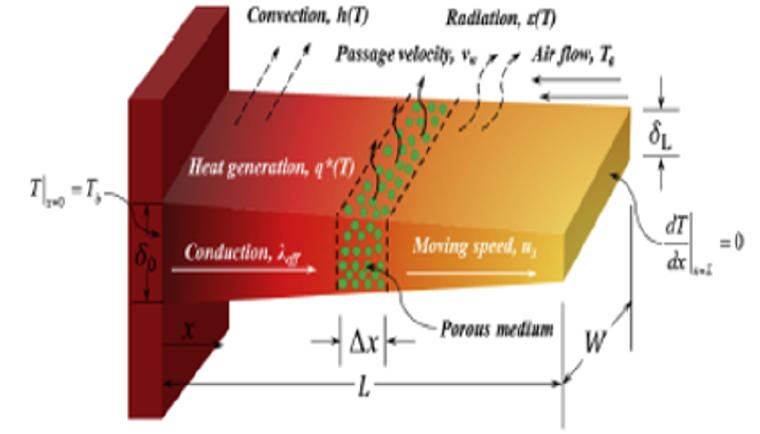
Figure 1. Trapezoidal fin profile